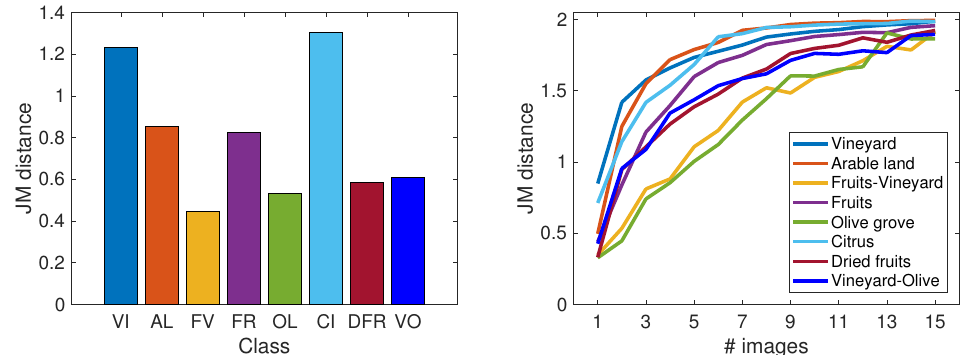
Figure 3. Jeffries–Matusita (JM) distances between active crop classes and the general class containing all the abandoned samples. To the left, the average distance is shown. To the right, the increase in JM distance as more images are stacked together is